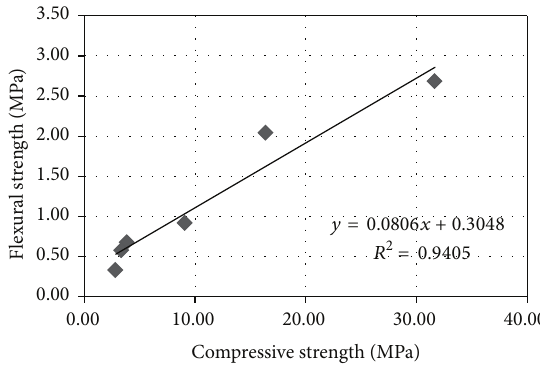
Figure 7: Correlation between the compressive strength and the flexural